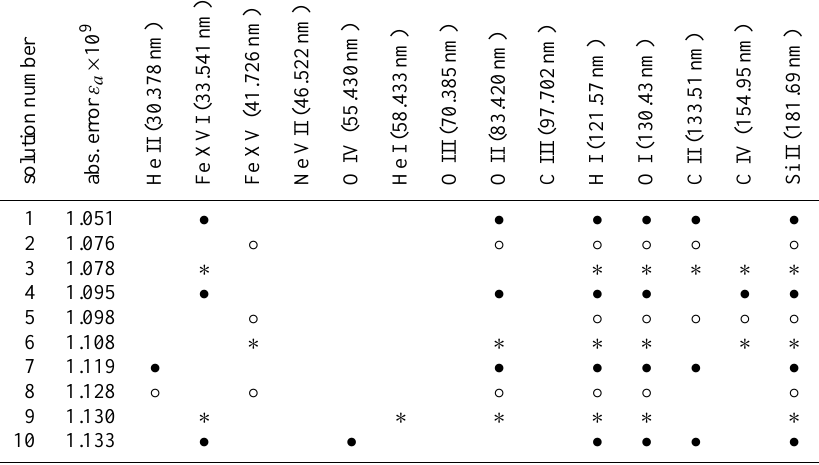
Table 2. The 10 best combinations of lines for reconstruction the full EUV spectrum using 6 spectral lines. These combinations minimise the average absolute error. Each row corresponds to one combination. The errors are expressed in flux units squared. Different symbols are used only to ease reading.